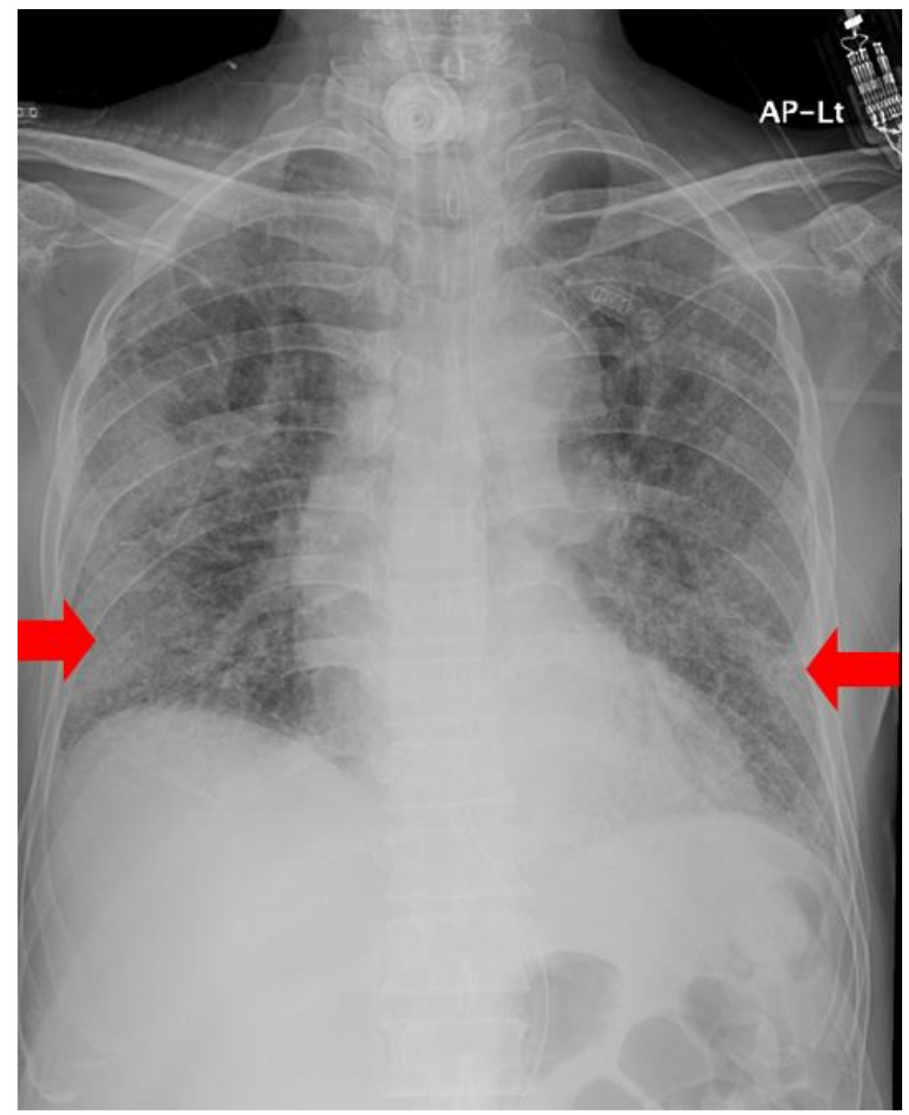
Figure 3. A chest radiograph obtained on Day 7 of MSC transplantation shows decreased haziness on both lower lung fields (red